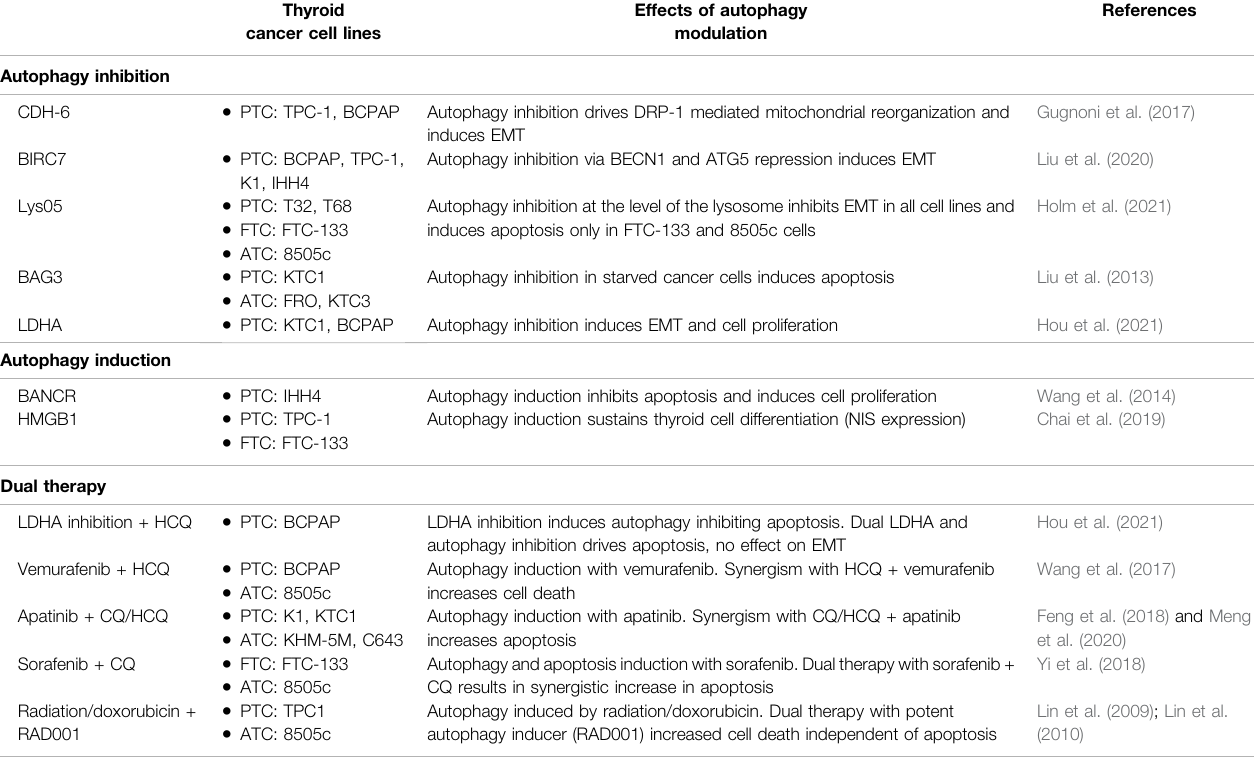
TABLE 1 | Effects of autophagy modulation in thyroid